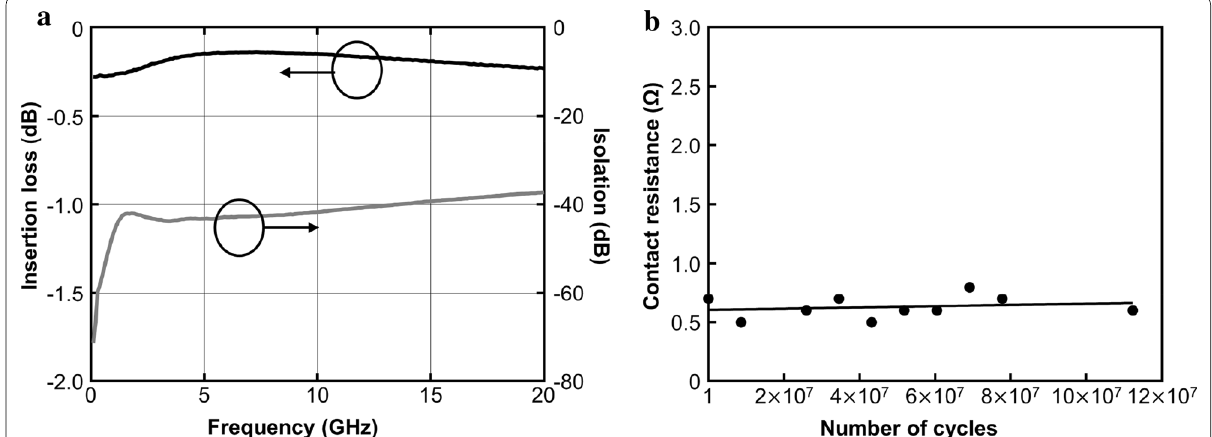
Fig. 5 Measured RF characteristics of the RF MEMS switch integrated in the fabricated MEMS tunable inductor. a Insertion loss and Isolation values of the switch at various signal frequencies. b Contact resistance according to the number of switching times